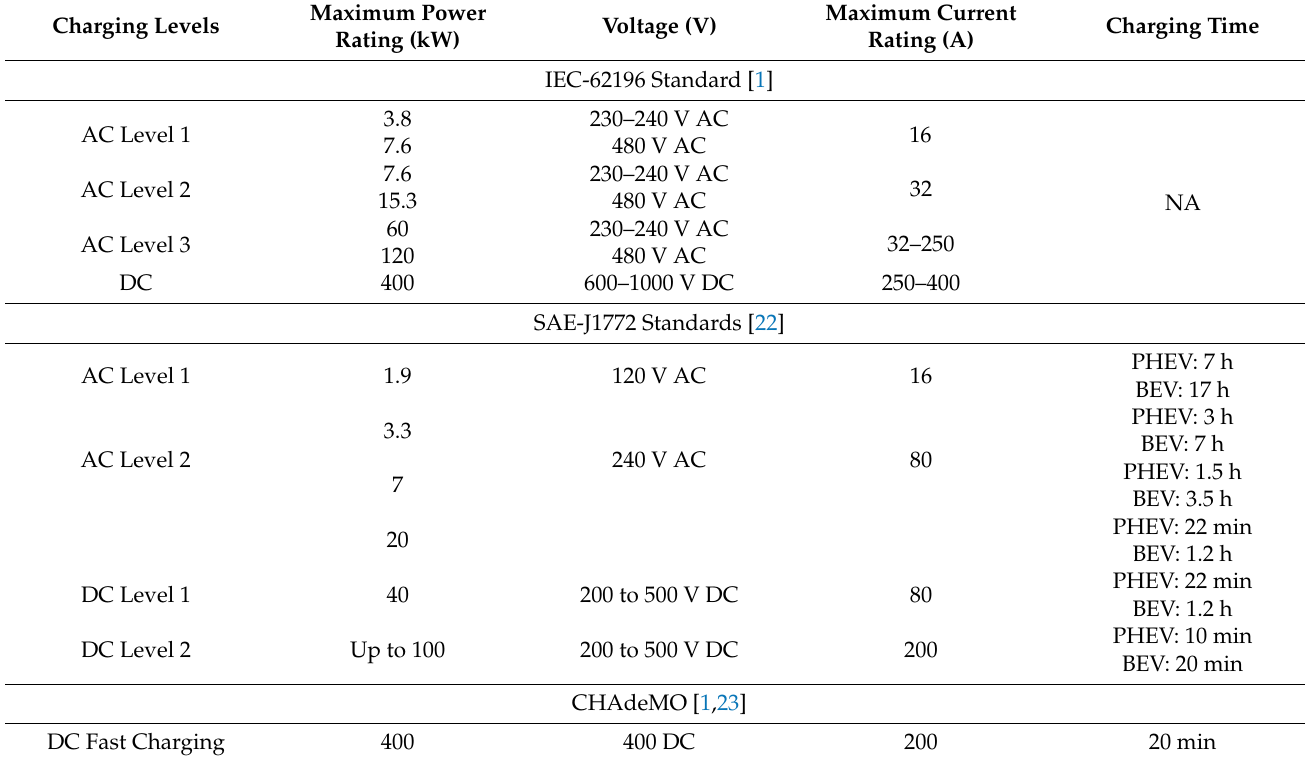
Table 1. Charging rates of IEC standards, SAE standards, and